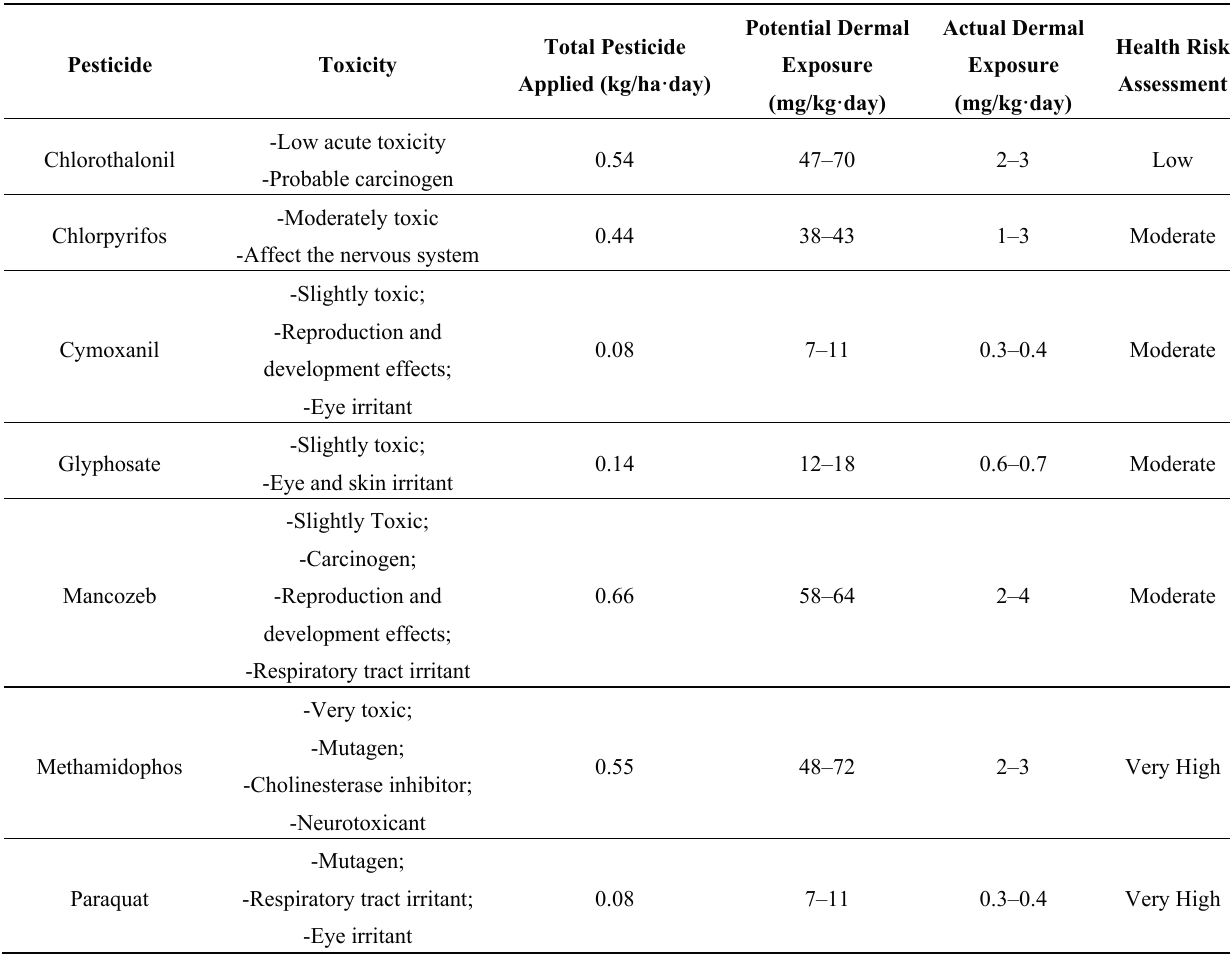
Table 2: Pesticides commonly used in Vereda La Hoya and their Health Risk Assessment